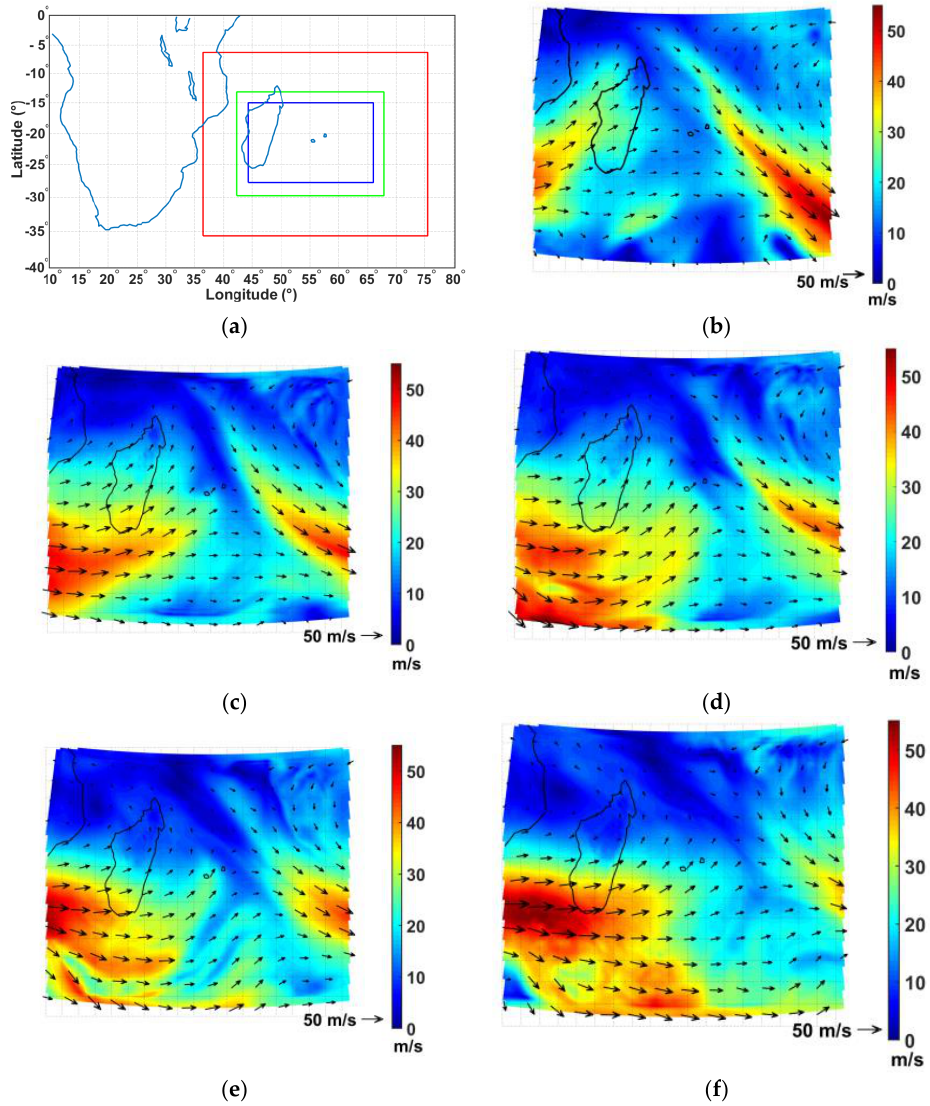
Figure 5. WRF simulation from 8 October at 0600 UTC to 12 October at 1200 UTC 2017: ( a ) Nested domains with horizontal grid spacing of 27 km (D1), 9 km (D2) and 3 km (D3); Wind intensity (color) and wind direction (arrows) at 10 km height derived from domain D1 on ( b ) 8 October 0600 UTC, ( c ) 9 October 1200 UTC, ( d ) 10 October 0000 UTC, ( e ) 10 October 1200 UTC and ( f ) 11 October 0000 UTC. The length of arrows indicates the wind intensity.